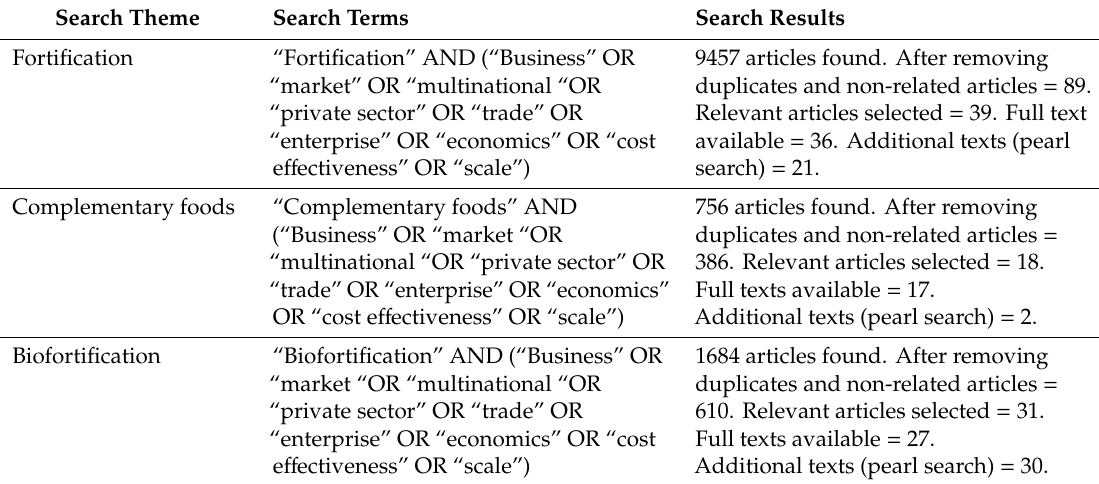
Table 1. Theme and terms used in the literature